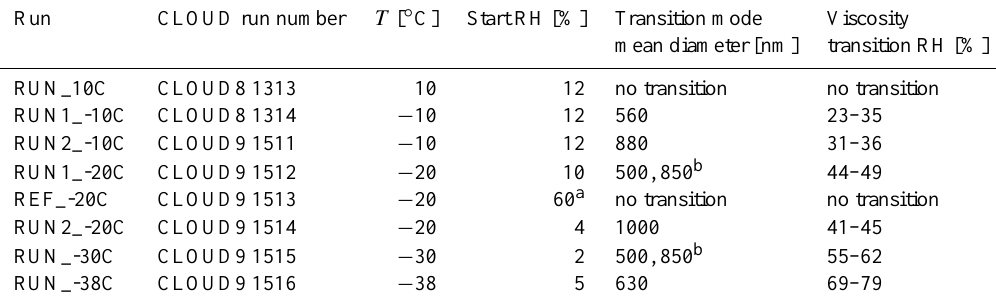
Table 1. Experiment list with experiment run number, starting temperature, relative humidity at the beginning, particle size before transition started, and measured relative humidity range for the viscosity